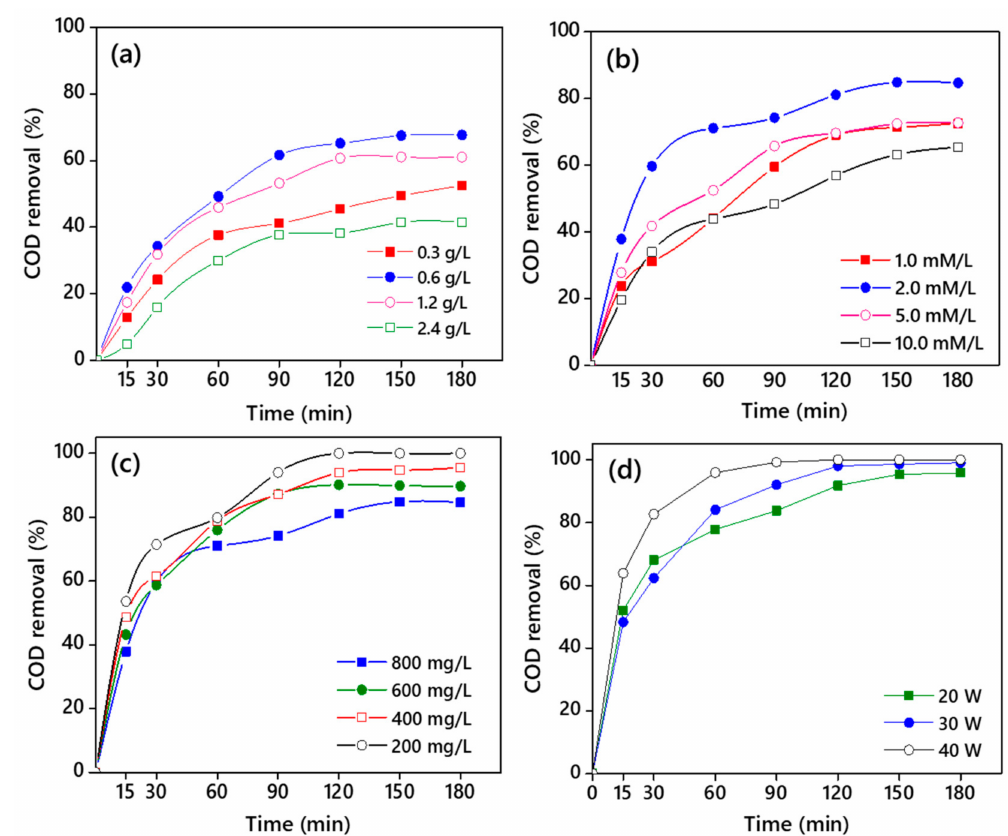
Figure 9. ( a ) COD removal efficiency from TPOME via sonophotocatalysis ( a ) effect of CNB-TiO 2 loading ( b ), effect of H 2 O 2 dosage ( c ), effect of COD concentration, and ( d ) effect of ultrasound